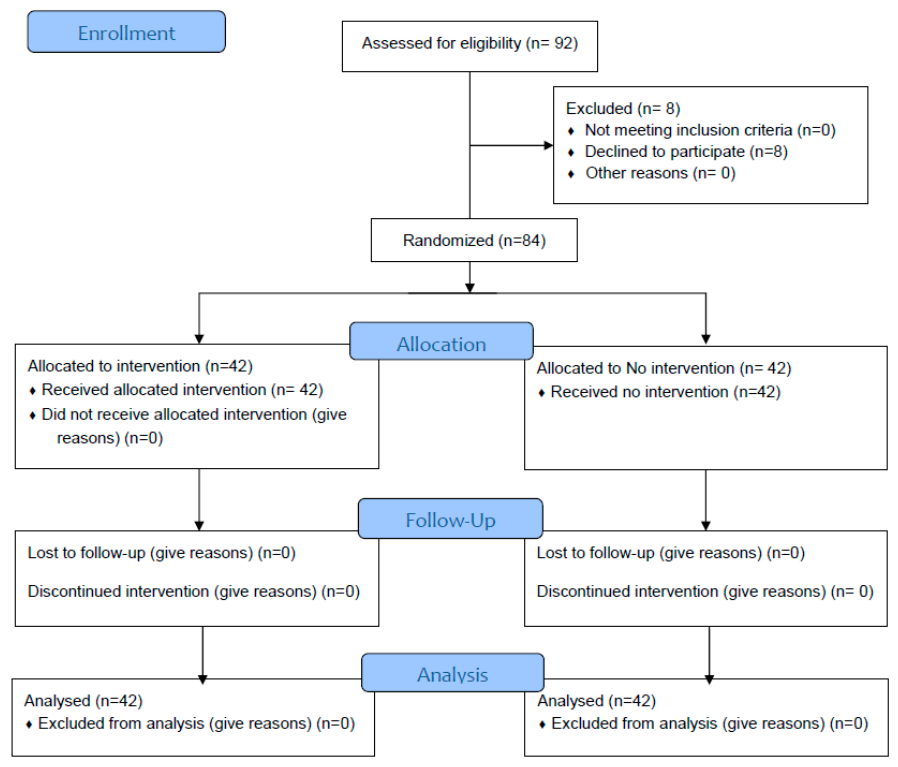
Figure 1. CONSORT 2010 Flow Diagram.